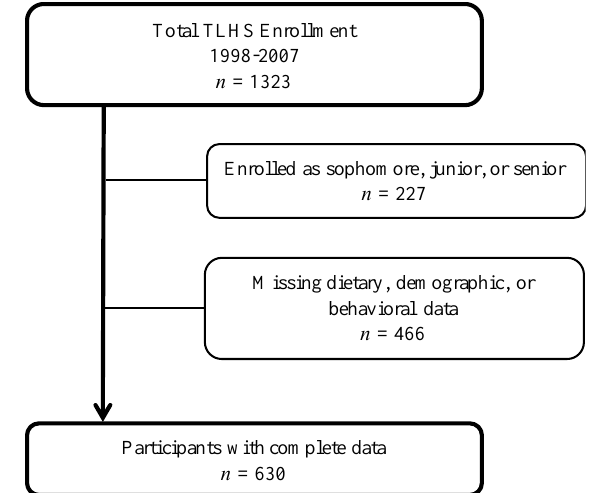
Figure 1. Flow chart depicting the final analytic sample. Boxes to the right indicate the number of participants excluded for each reason.